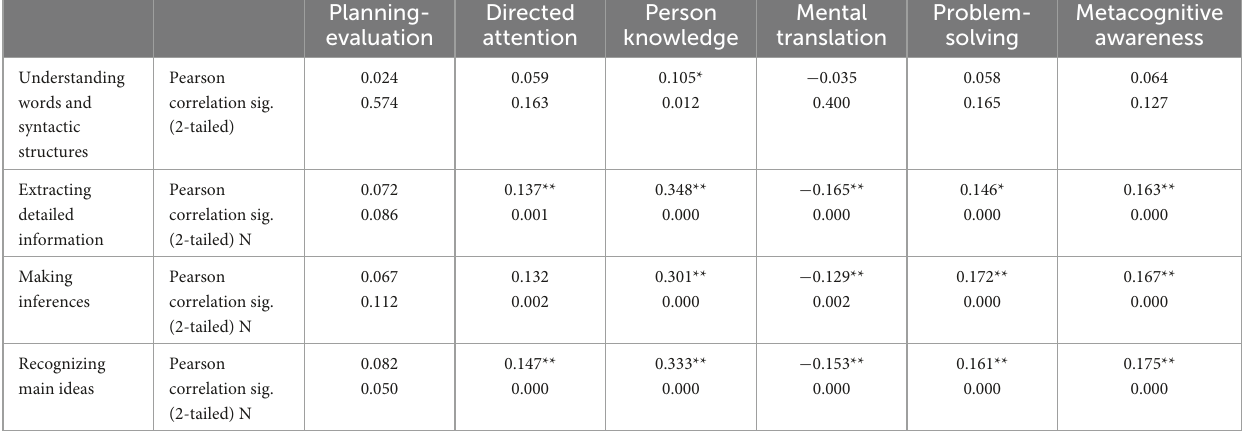
TABLE 6 Correlations between metacognitive awareness and listening